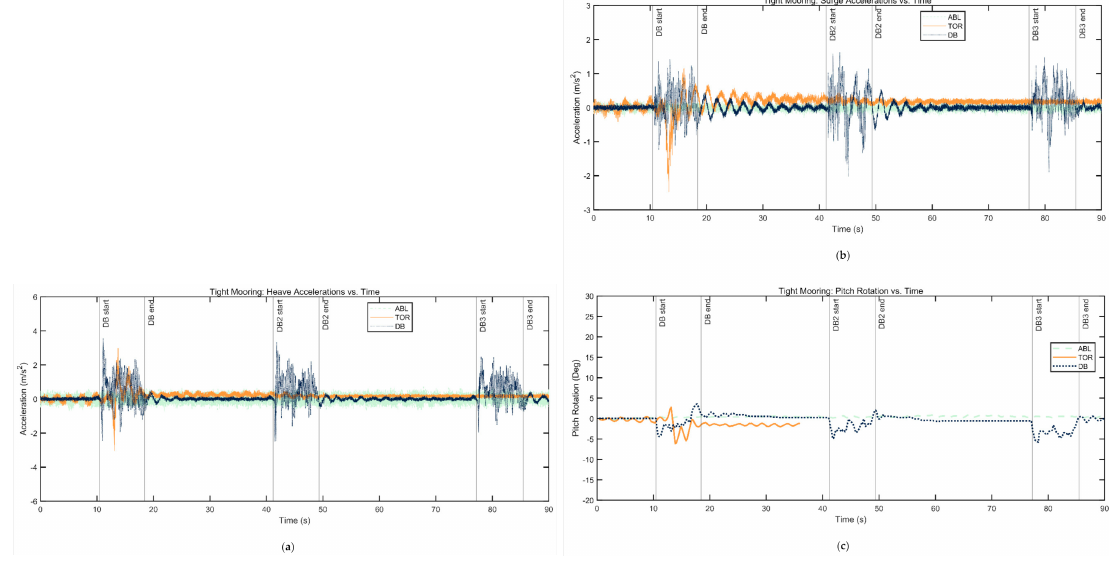
Figure 11. ( a ) Heave acceleration, ( b ) Surge acceleration, and ( c ) Pitch rotation of Configuration 2-Tightly moored base plat- form.